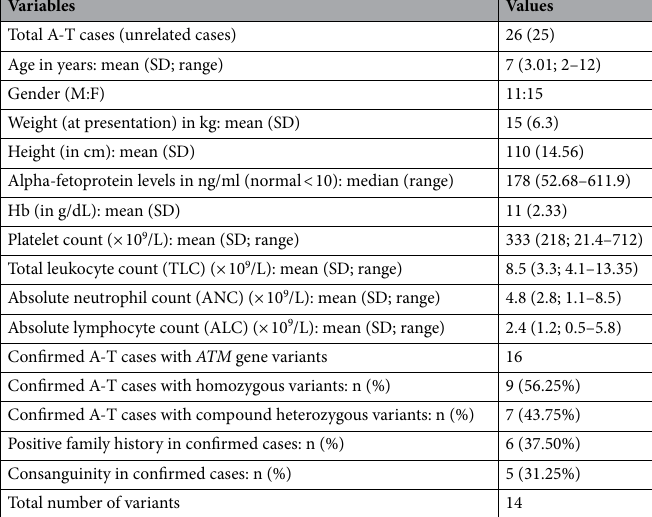
Table 1. Baseline characteristics of A-T cases.